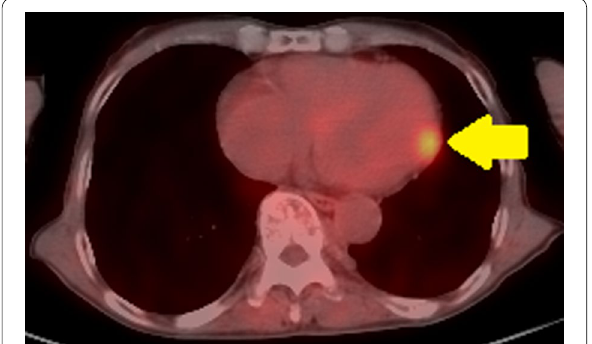
Fig. 3 PET showed a high degree of FDG accumulation in the left ventricular myocardium